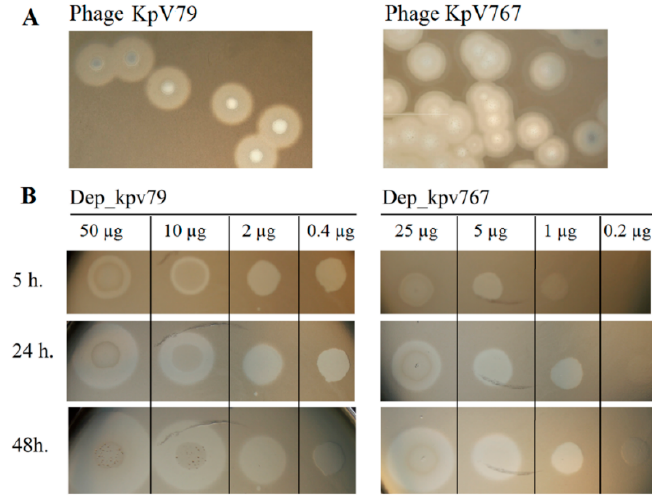
Figure 1. The activity of depolymerases Dep_kpv79 and Dep_kpv767 against Klebsiella pneumoniae strains. ( A ) Haloes surrounding phage KpV79 and KpV767 plaques, suggesting the presence of phage